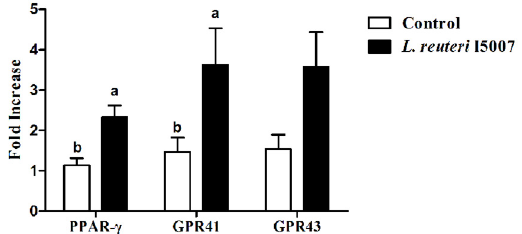
Figure 4. Effects of L. reuteri I5007 on PPAR- γ , GPR41, and GPR43 expression in the colonic tissue of neonatal piglets. Gene expression was analyzed by real-time PCR. The relative fold changes over the control were calculated with the ΔΔ C t method using the β‐ actin gene for normalization. Data are